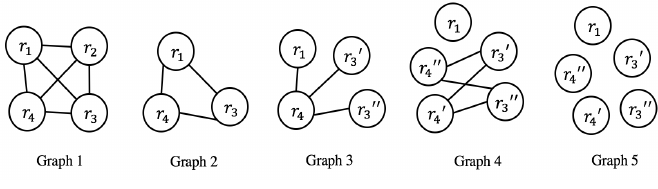
Figure 1. Constructed graphs from the cluster presented in example